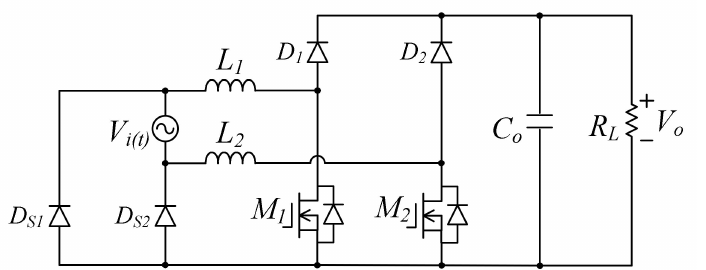
Figure 3. Schematic diagram of the bridgeless boost converter with low CM noise for PFC applications.